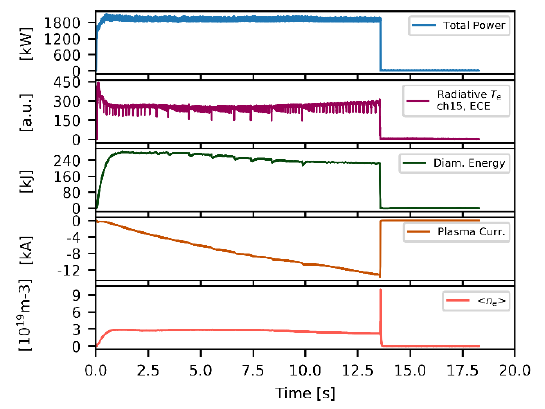
Figure 2: ECCD discharge example. It is possible to notice repetitive temperature crashes on the ECE channel (in